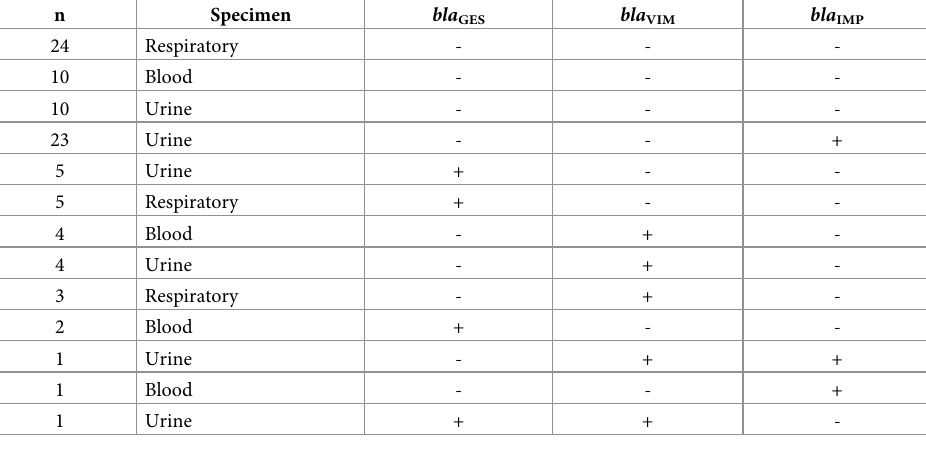
OXA-48-like carbapenemases are important causes of carbapenem resistance and are now